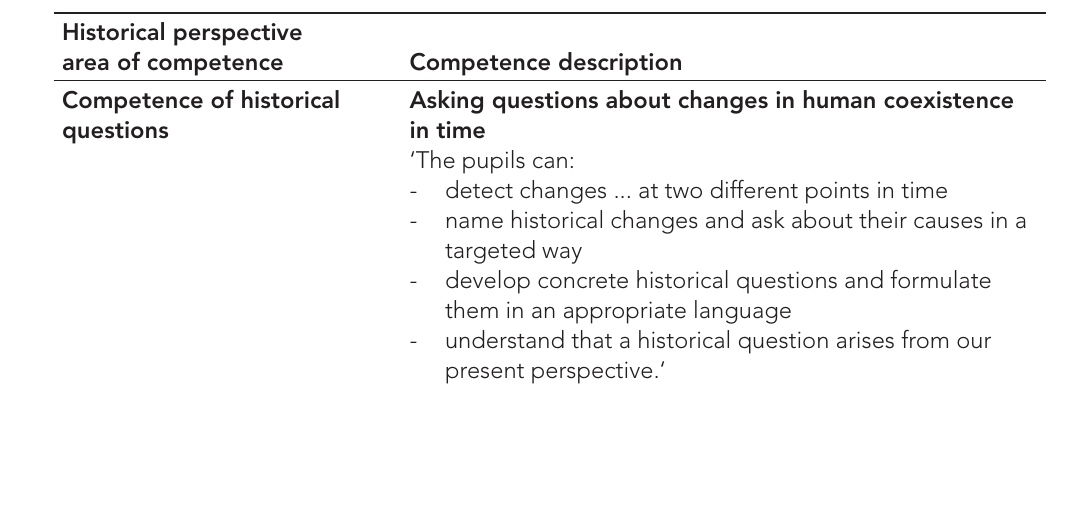
Table 1: Areas of competence of historical learning in primary